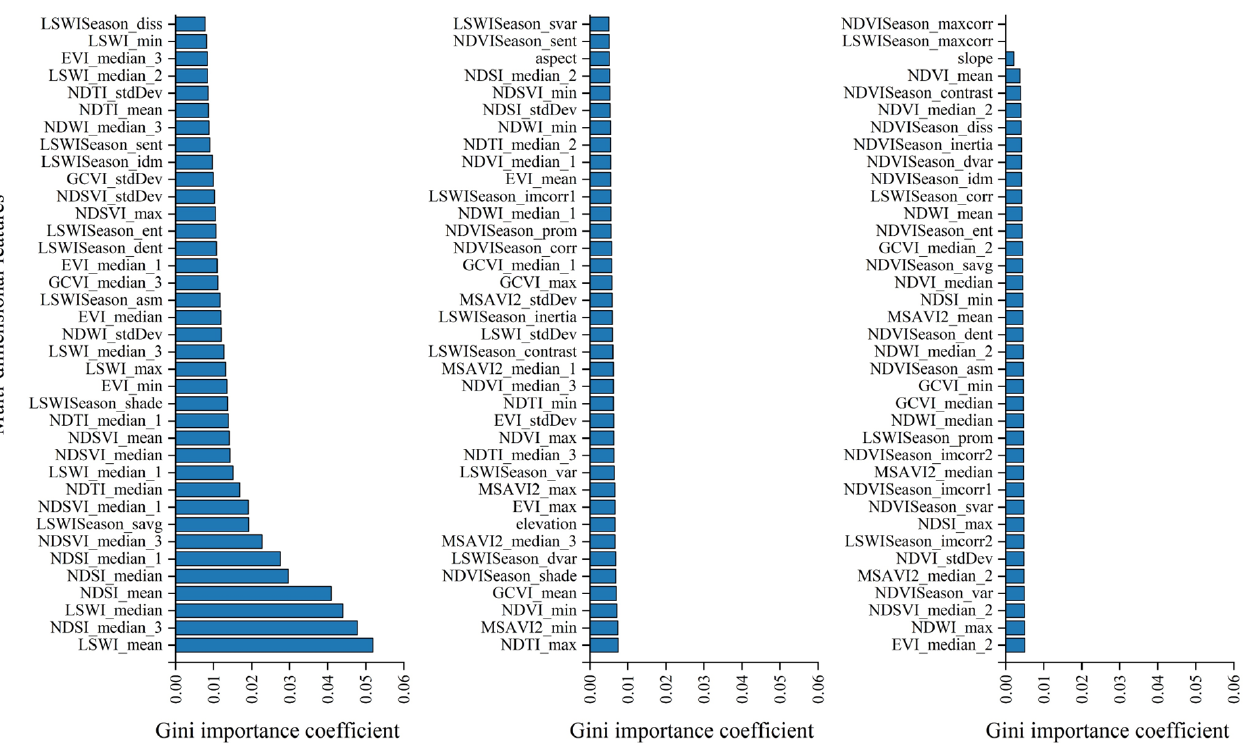
Figure 3. Ranking Gini importance coefficients of 111-dimensional spectral, temporal, spatial, and topographic features.